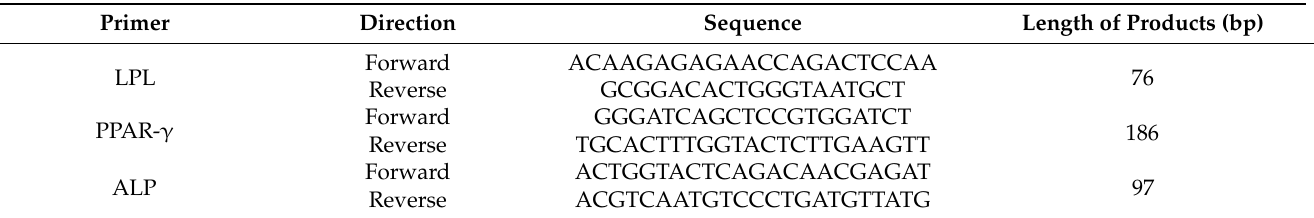
Table 1. Primer sequences of adipogenic- and osteogenic-induced gene